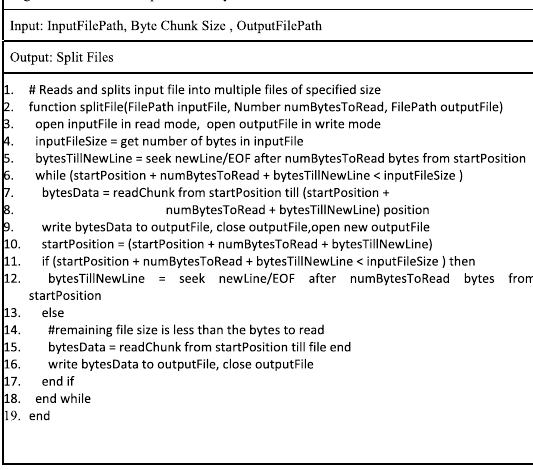
Algorithm 1. StartByteLocation works as a relay baton